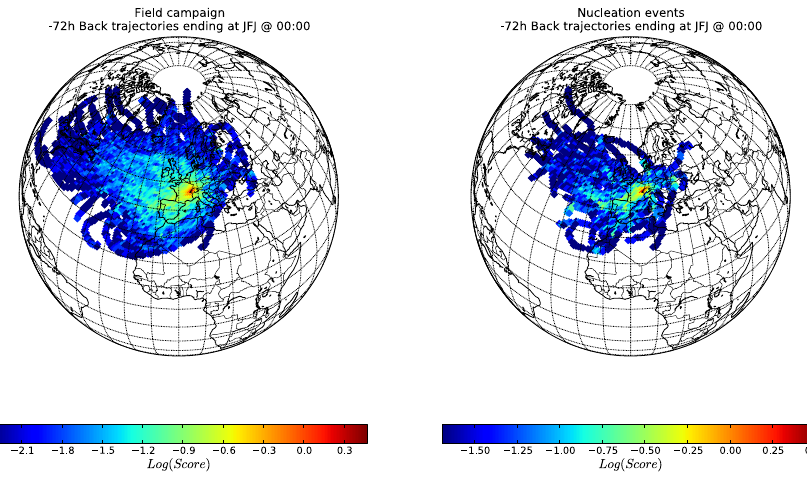
Fig. 6. Three days air mass backtrajectories ending at the measurement site at 00:00 LT for all the field campaign ( right panel ) and for new particle formation events ( left panel ). The score is the number of occurence of a given geographical position.